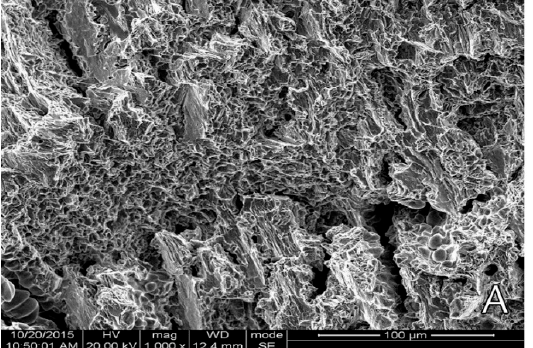
Figure 7. Fracture surface of a cast cobalt–chromium alloy tensile specimen showing cleavage fracture pattern [173].